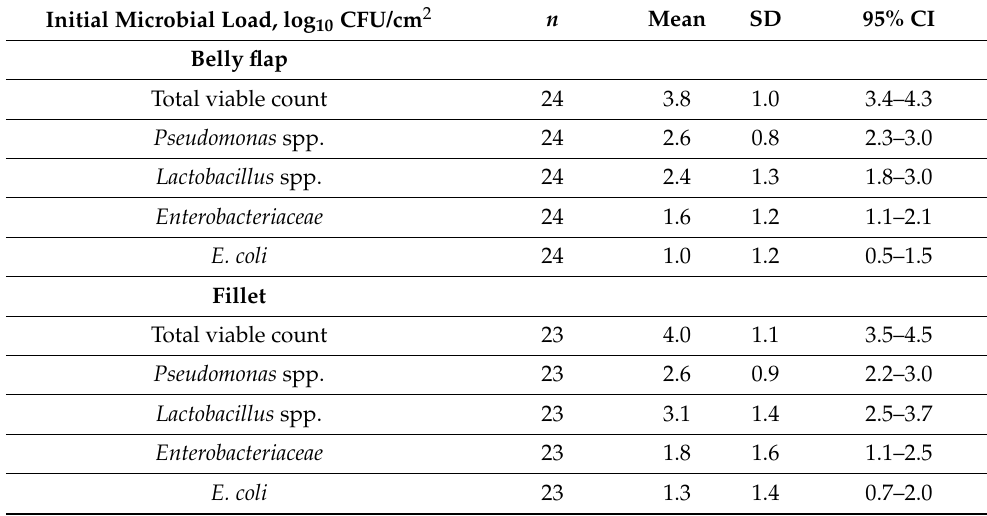
Table 2. Mean, standard deviation (SD) and 95% confidence intervals (95% CI) of the initial microbial load on the meat surface of belly flap ( n = 24) and fillet ( n = 23) of roe deer carcasses. Initial Microbial Load, log 10 CFU/cm 2 n Mean SD 95% CI Belly flap Total viable count 24 Pseudomonas